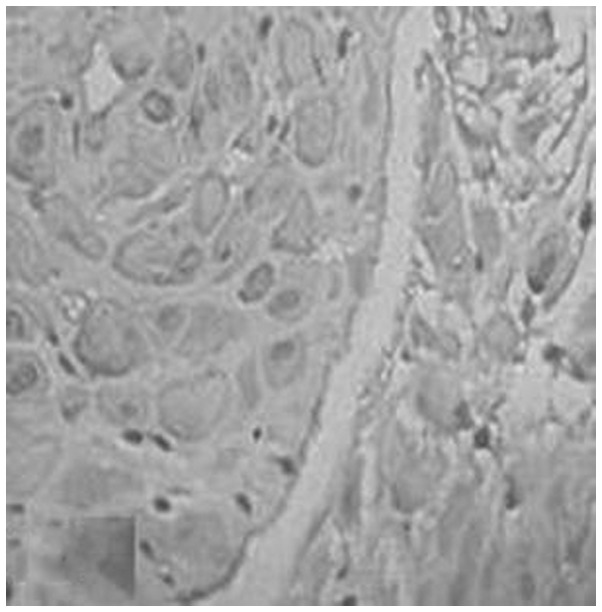
Immunohistochemical staining for tissue inhibitor of metalloproteinase-1 in a normal decidua. Magnification, ×400.